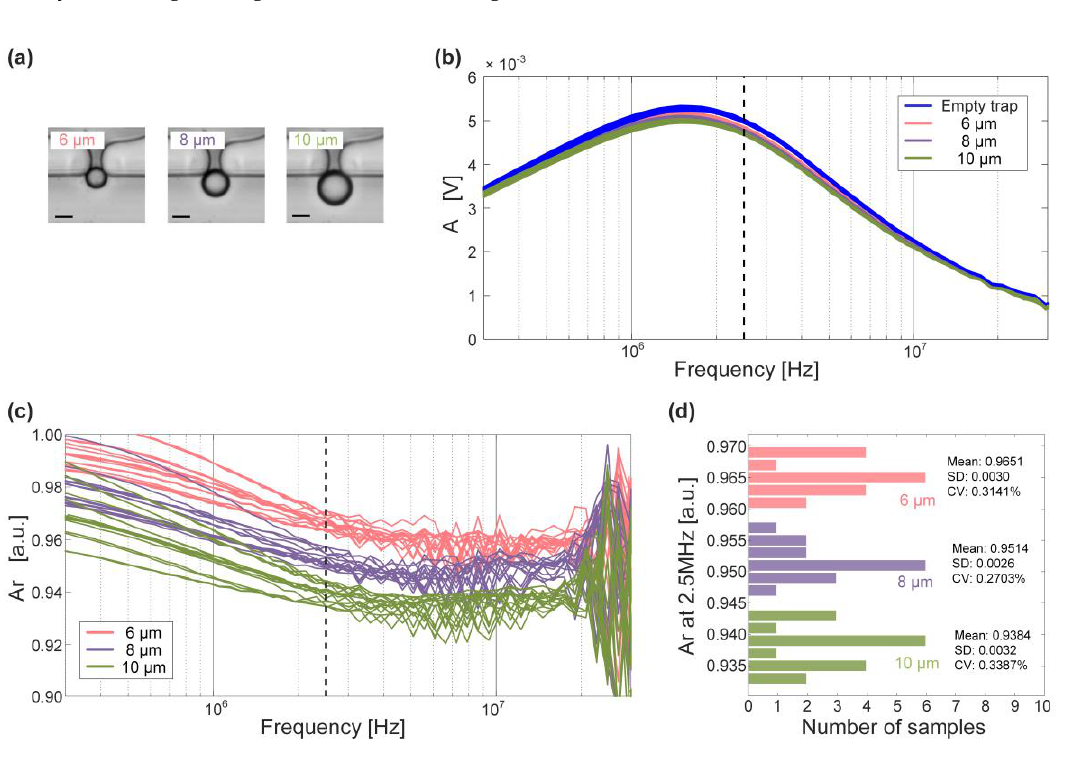
Figure 17. Electrical impedance measurement of beads in the microfluidic device. ( a ) Micrographs of immobilized beads with different diameters. Scale bar is 5 μm. ( b ) Raw amplitude of electrical impedance spectroscopy (EIS) signals over the swept frequency from 300 kHz to 30 MHz. ( c ) Relative amplitude of EIS signals over the swept frequency from 300 kHz to 30 MHz. ( d ) Histogram of relative amplitude of measuring 6 μm, 8 μm, and 10 μm beads at 2.5 MHz.